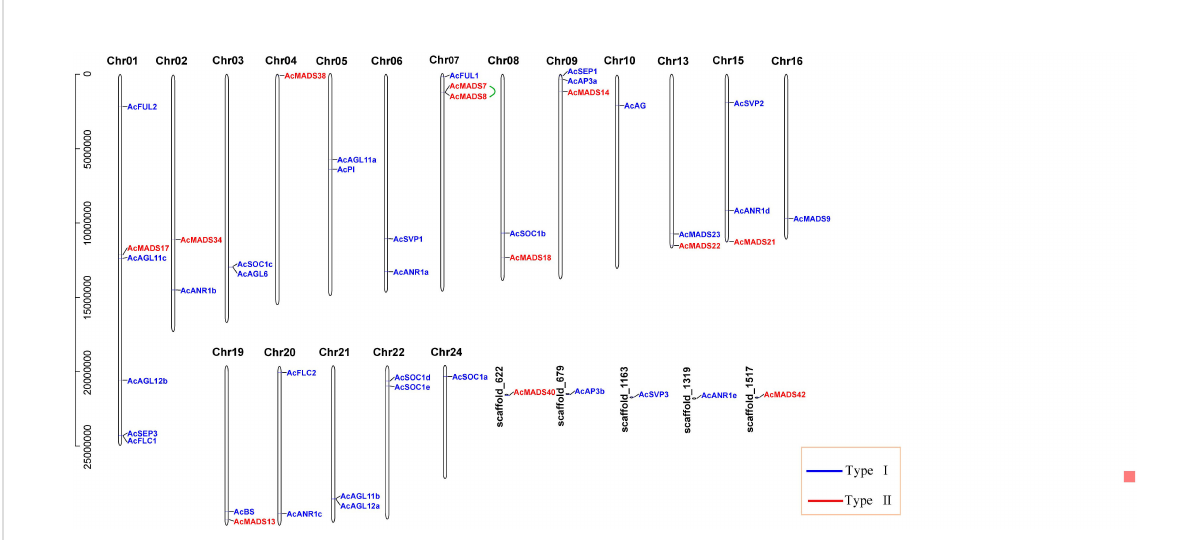
FIGURE 3 Distribution of AcMADS genes on the pineapple chromosomes. The black vertical lines indicate the pineapple chromosome (Chr), the number is above the Chr, and the tandemly duplicated genes were connected by the green line. The different groups of AcMADS genes were color-coded.